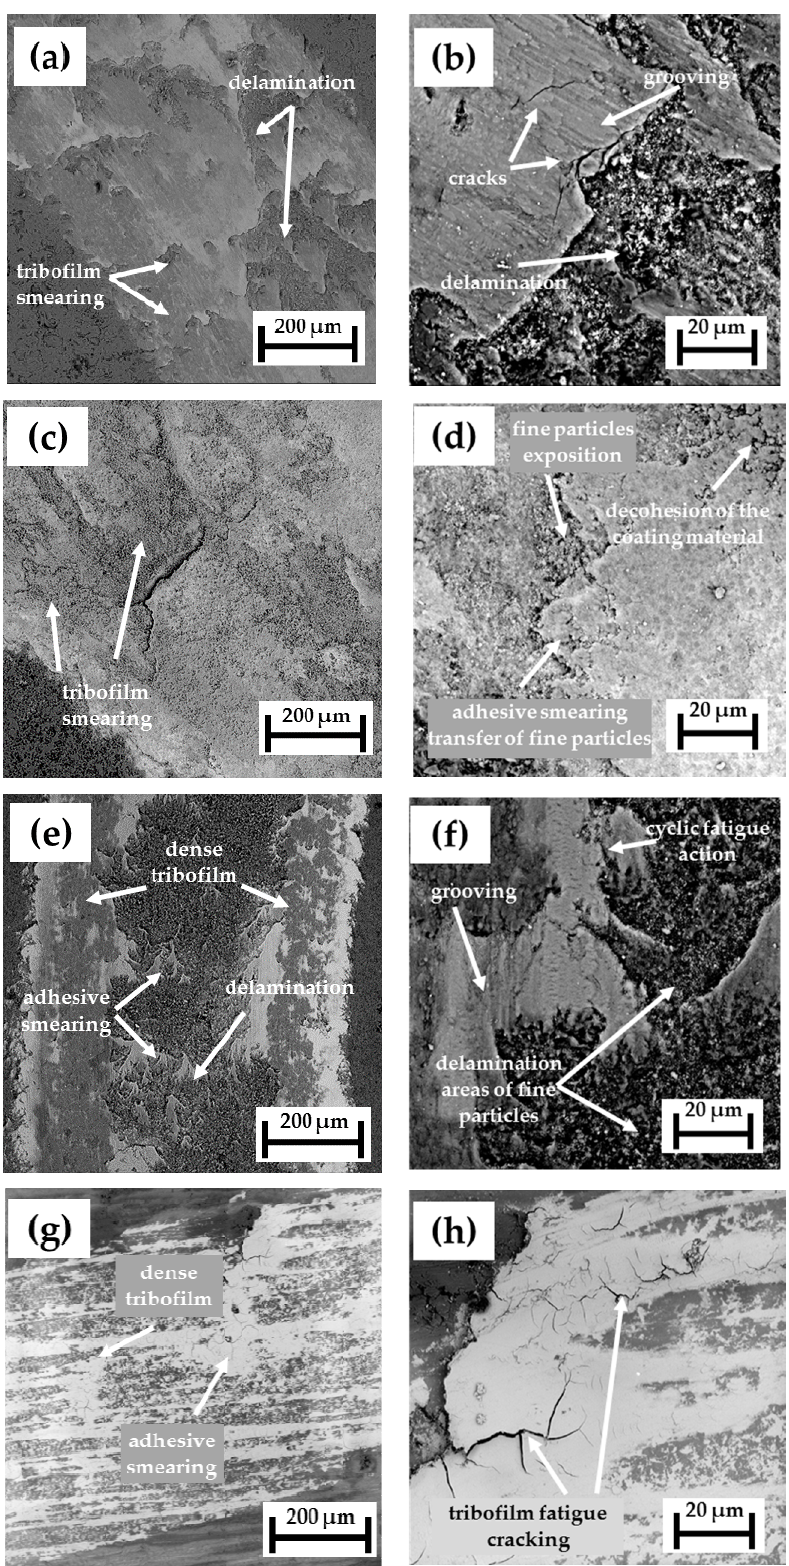
Figure 7. The wear traces of different alumina coatings, deposited using: ( a , b ) APS; ( c , d ) SPS; ( e , f ) A-SPS; ( g , h ) S-HVOF techniques.